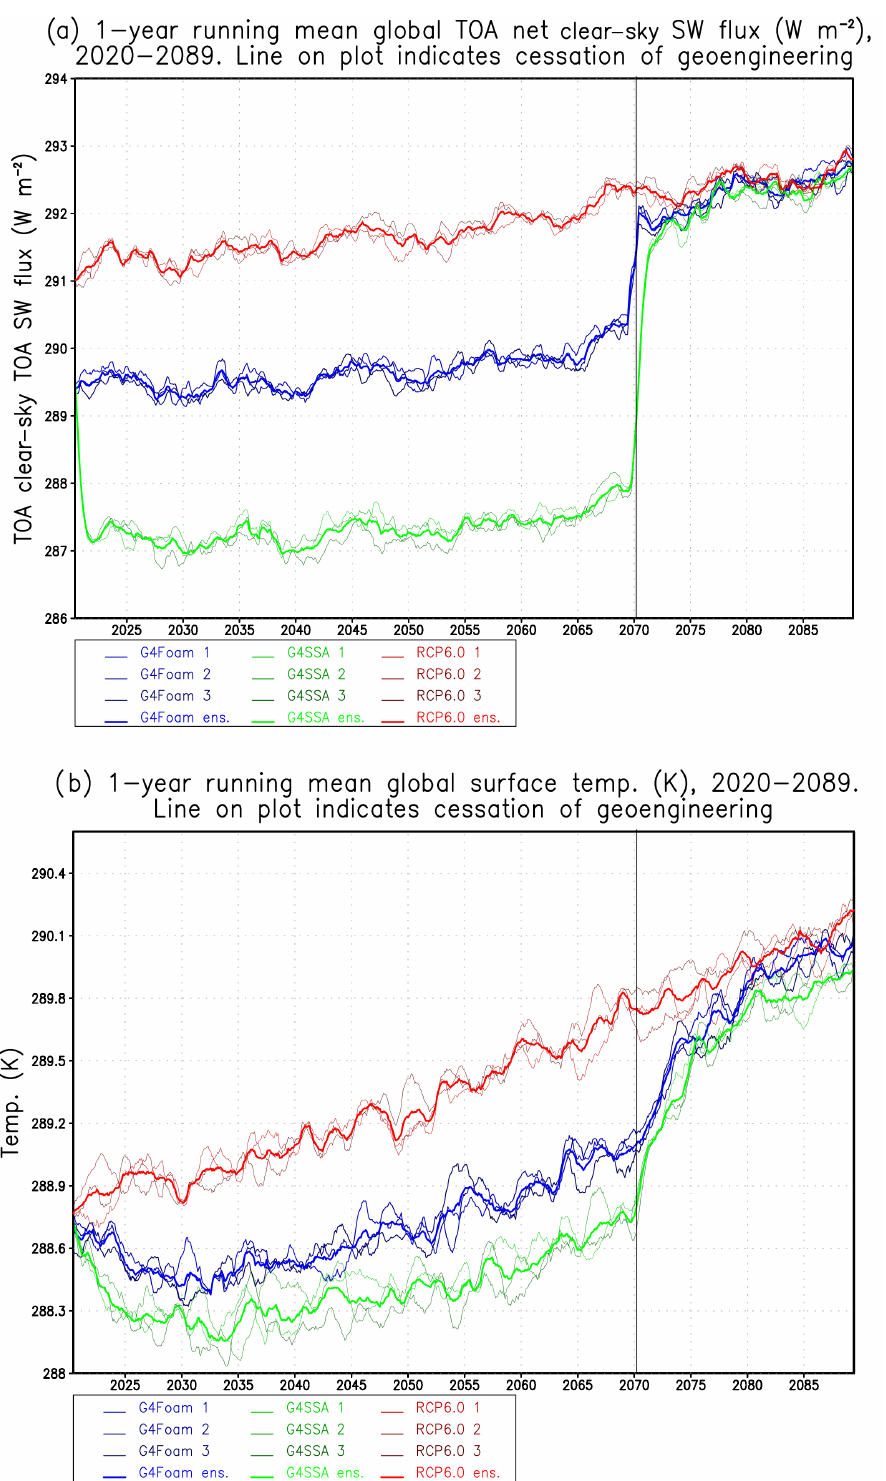
Figure 3. (a) Net clear-sky SW flux at top of atmosphere, which includes the effects of changes in radiation caused by changes in ocean surface albedo or land albedo (ice and snow), as well as stratospheric aerosols (stratospheric geoengineering) and (b) time series of global mean temperature. In G4Foam, temperature is more than twice as sensitive to ocean albedo forcing as it is to stratospheric geoengineering, as applied in G4SSA, albeit with very different latitudinal distributions of temperature changes. Each ensemble member and the ensemble mean are shown for each